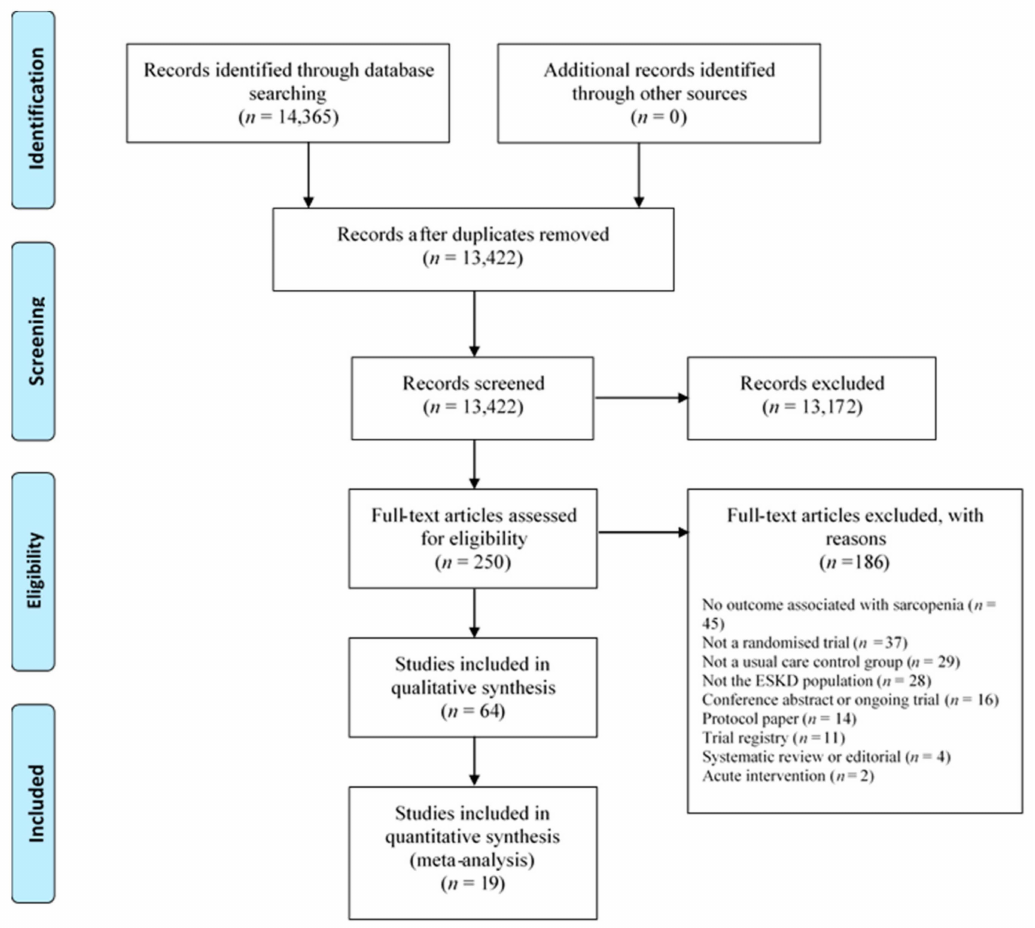
Figure 1. Prisma flow diagram of trial selection. ESKD = end stage kidney